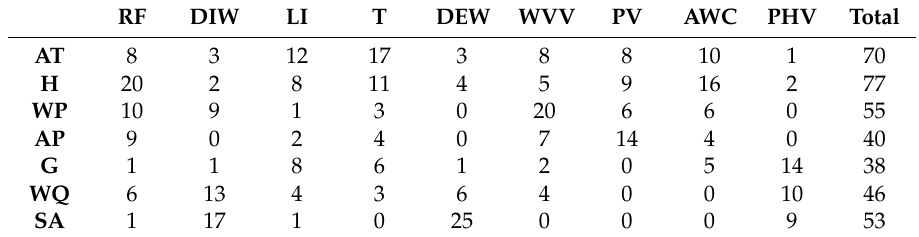
Table 4. Attribute intersection distribution of random forest division.